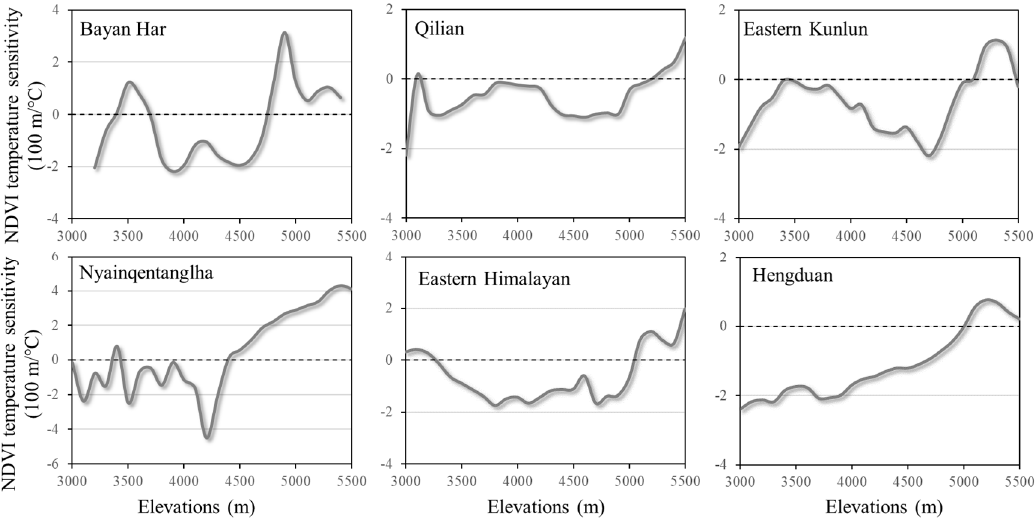
Figure 7. The sensitivity of the vertical movement of NDVI isoline to air temperature for the elevation bins in different mountainous regions.